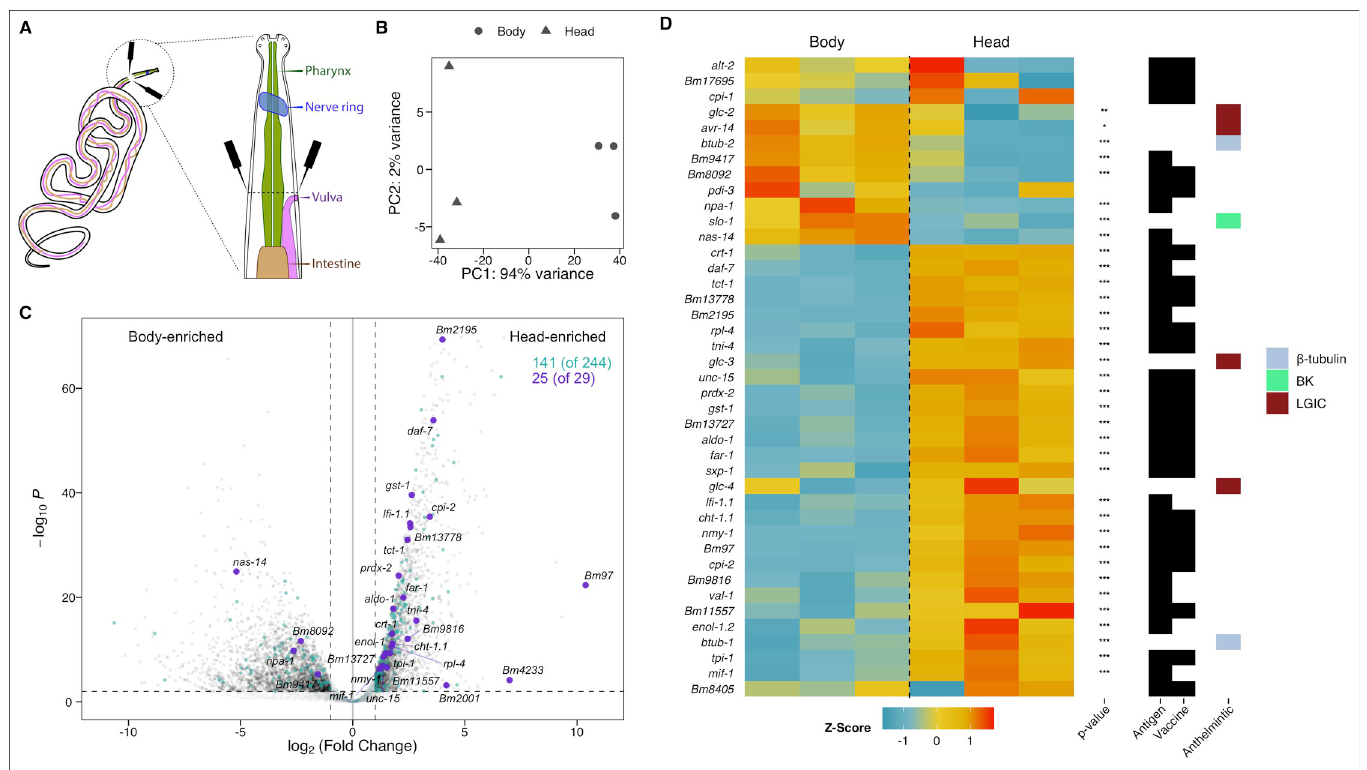
Fig 1. The B . malayi head transcriptome reveals enrichment of anthelmintic targets, prominent antigens, and vaccine candidates. (A) Illustration of head region tissues and point of dissection adjacent to the vulva (black probes). (B) Principal component analysis (PCA) plot of head and corresponding body transcriptome replicates. Each point represents tissue from a different parasite. (C) Volcano plot highlighting head enrichment of prominent antigens and immunomodulatory genes (25 of 29 genes; purple) [16,33,94–101], compared to a more diffuse pattern of expression for proteins identified in secretome studies (141 of 244 genes; teal) [31,32].(D) Heatmap of gene expression patterns shows head-enrichment of candidate vaccine targets, as well as both head- and body-enrichment for the targets of antifilarial drugs (benzimidazoles: β -tubulins, macrocyclic lactones: GluCls, and emodepside: BK channel) ( � p-value < 0.5, �� p-value < 0.01, ��� p-value < 0.001).